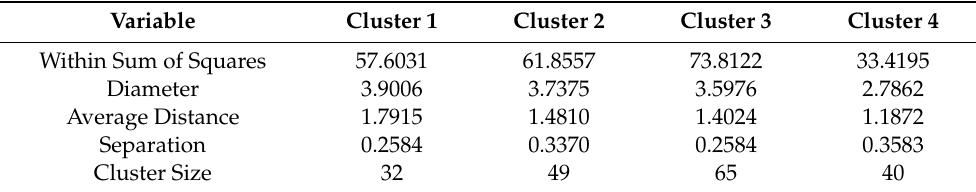
Table 3. Results of k-means clustering.